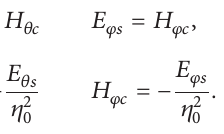
Figure 5: Return loss ( 𝑆 11 ) response of the proposed